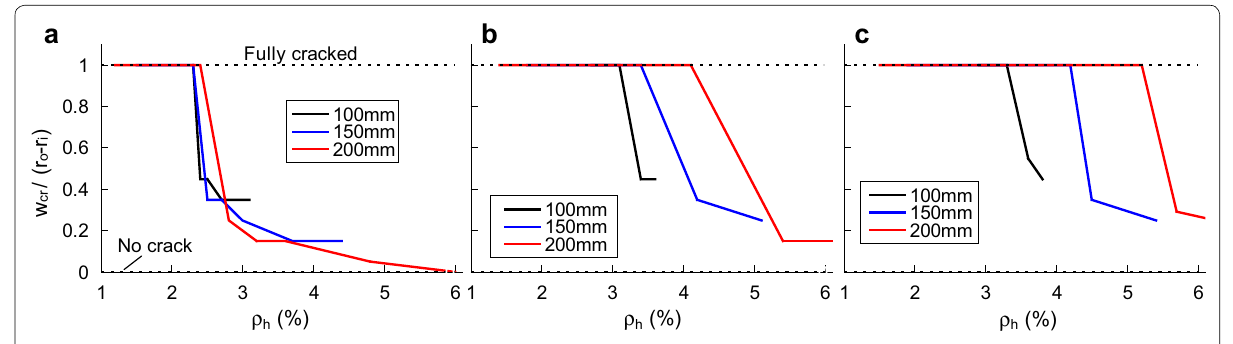
2.3%.; b ρ h 2.5%; c ρ h,max 3.1%. = = =